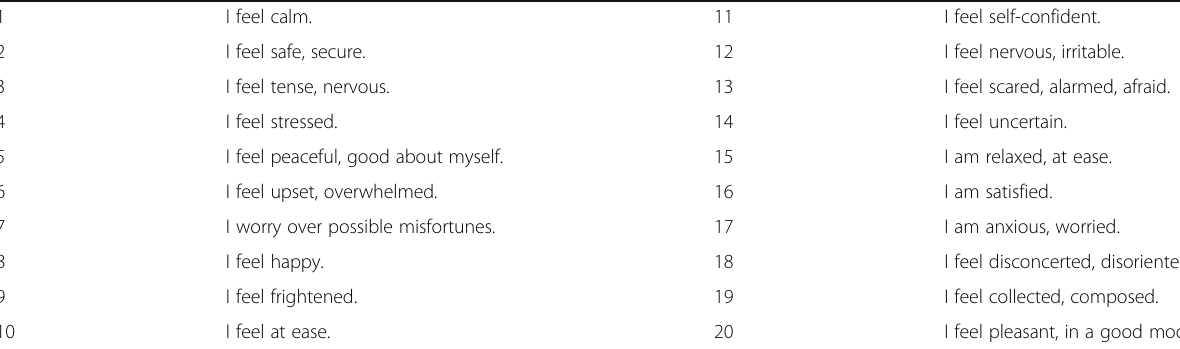
Table 1 Questions from State-Anxiety